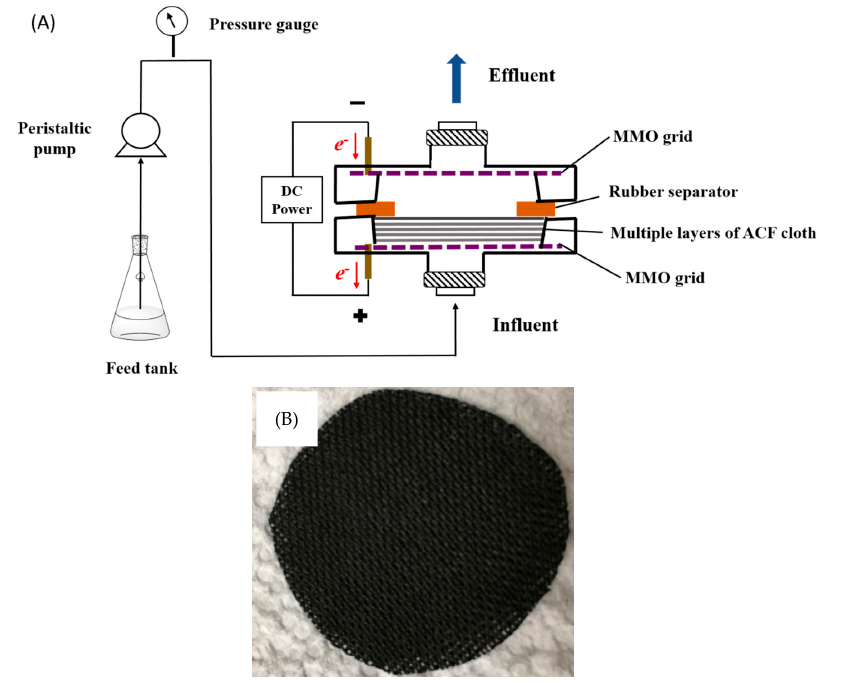
Figure 1. ( A ) A schematic diagram of the REM operation and ( B ) a picture of activated carbon fiber cloth (ACFC). MMO: mixed metal oxide.